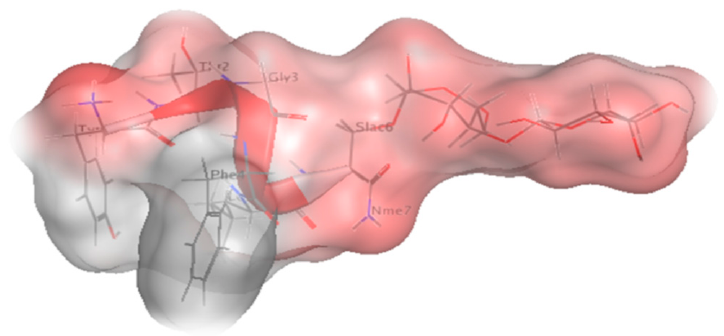
Figure 10. Molecular Surface of Lactomorphin with Hydrophilic ( red ) and Lipophilic ( gray ) zones.